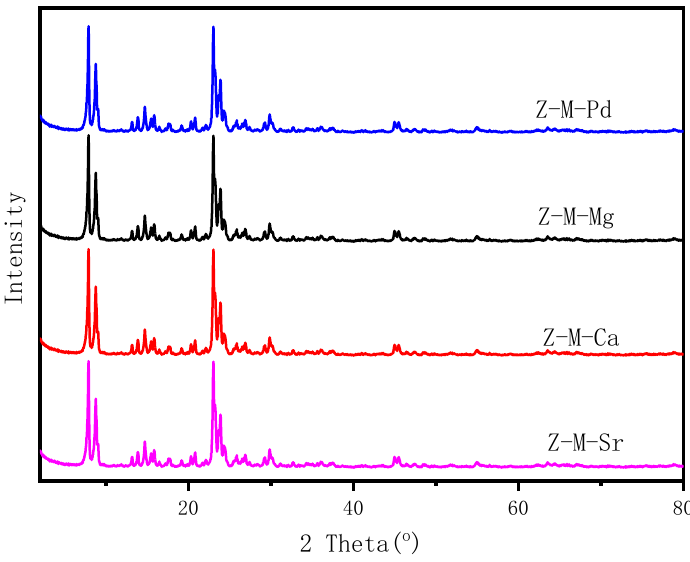
Figure 11. The XRD patterns of the mesoporous ZSM-5 zeolite modified by different metals.